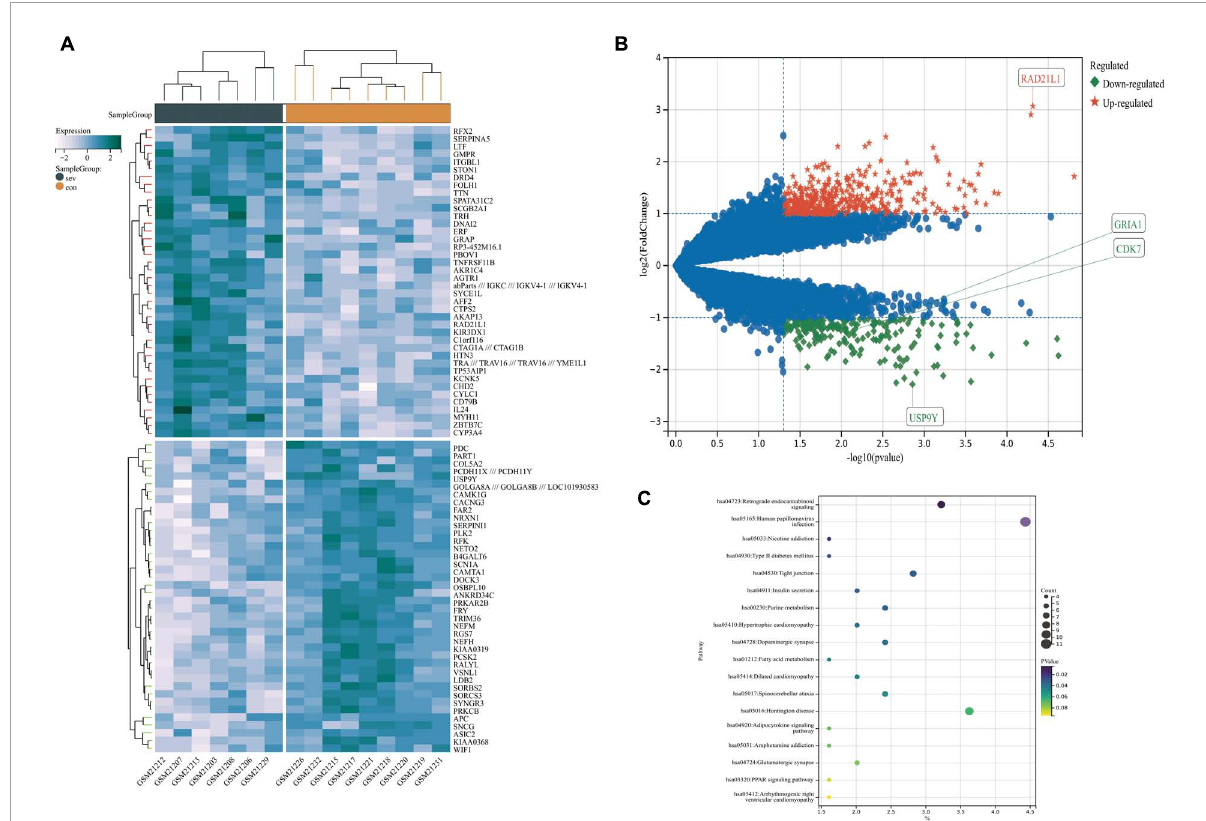
FIGURE5 The volcano plot, heat map, and pathway’s bubble diagram of DEGs. (A) A heat map of DEGs in GSE1297. (B) Volcano plot of DEGs in GSE1297. (C) Pathway bubble diagram of DEGs screened by weighted correlation network analysis (WGCNA). There are also two horizontal dashed lines in the panel (B) , representing log2FC at –1 and 1, The vertical dashed line represents the adjusted p -value at 0.05, RAD21L1 and USP9Y represented the genes with the largest and smallest difference, respectively, GRIA1 and CDK7 are the key genes in this study. DEGs, differentially expressed